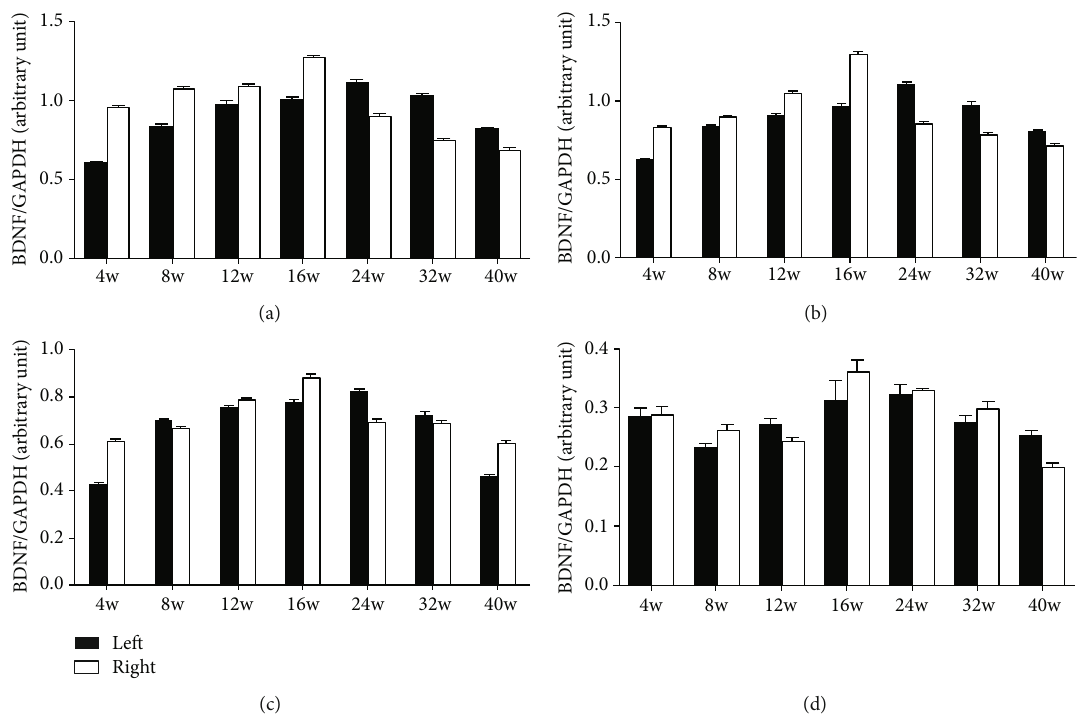
Figure 5: Western blot shows the comparison of the BDNF protein levels (normalized to GAPDH) between the left and right hemispheres. No signi fi cant di ff erence was found between the left and right hemispheres. Data are expressed as mean ± SD (Student ’ s t -test): (a) entire root group, (b) entire root+posterior division group, (c) posterior division group, and (d) blank control group.